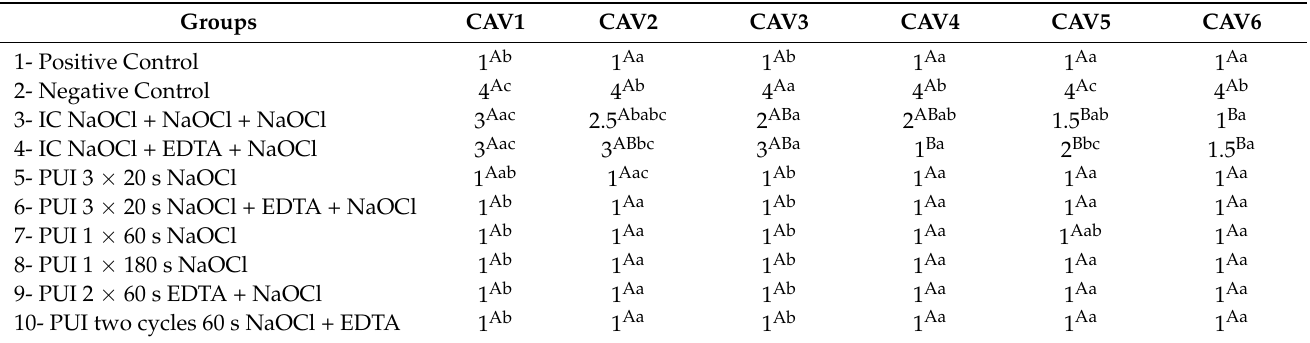
Table 2. Analysis of the general cleaning achieved for each protocol used in every individual cavity ( p <